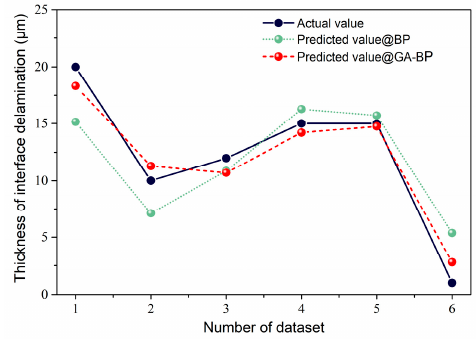
Figure 9. Prediction results of the interface delamination thickness of the BP and GA–BP regression model.